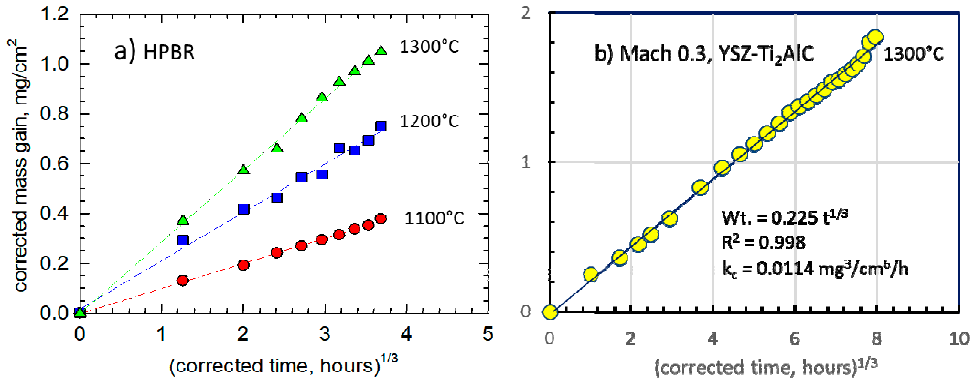
Figure 3. Cubic oxidation kinetics suggested by linearized transient-corrected weight vs t 1/3 behavior for Ti 2 AlC. ( a ) 6 atm, 25 m/s, 50 h, HP-BRT; and ( b ) 1 atm., 100 m/s, 500 h, Mach 0.3 BRT, with YSZ face-coat [13,15].